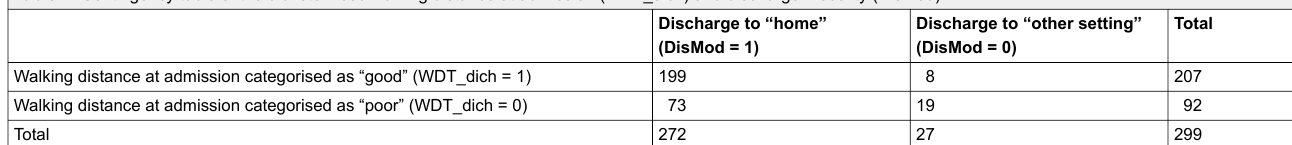
Table 4: Contingency table of the dichotomised walking distance at admission (WDT_dich) and discharge modality (DisMod).